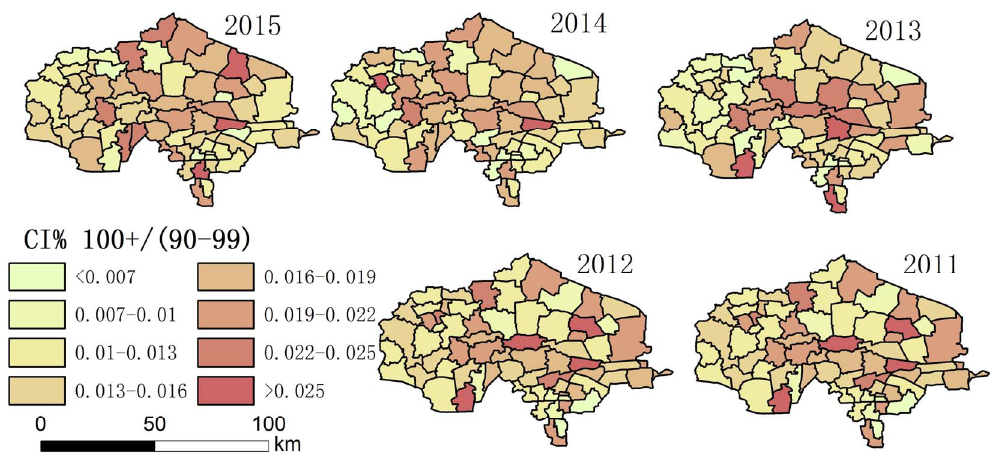
Figure 7. The proportion of the population over 100 in comparison with those aged 90–99 (CI%) in each town.